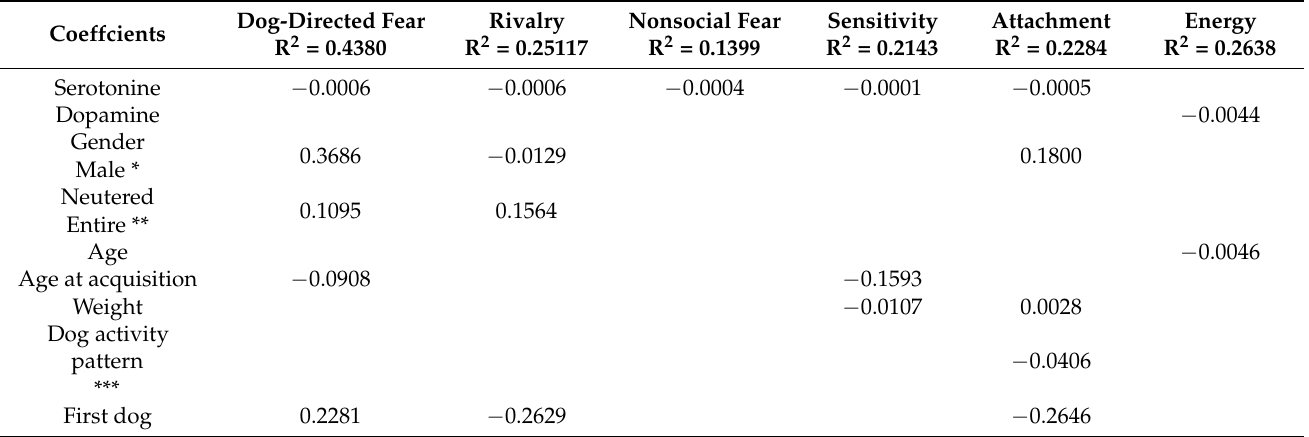
Table 5. Results of Lasso regression models for the effects of serotonin and dopamine serum concen- trations in dogs on scores (over and under the median) for the different C-BARQ